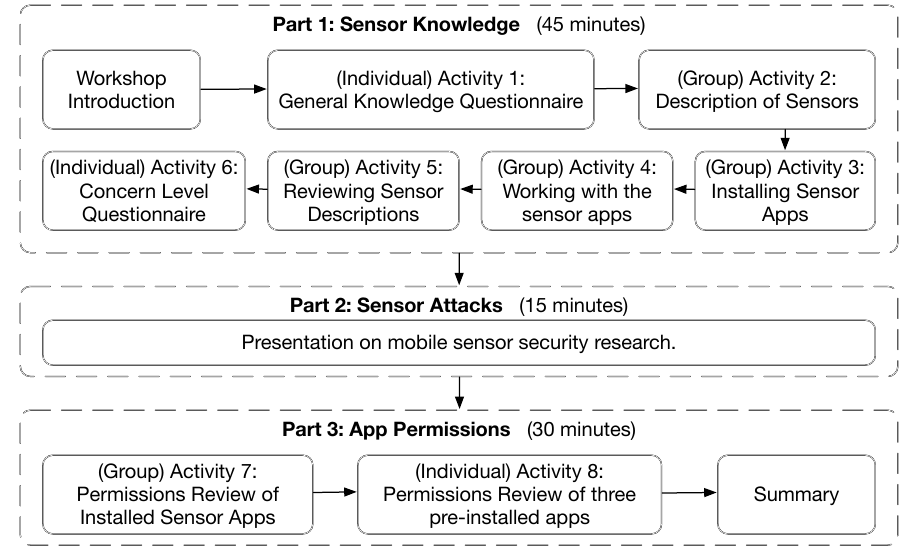
Figure 1. The workshop